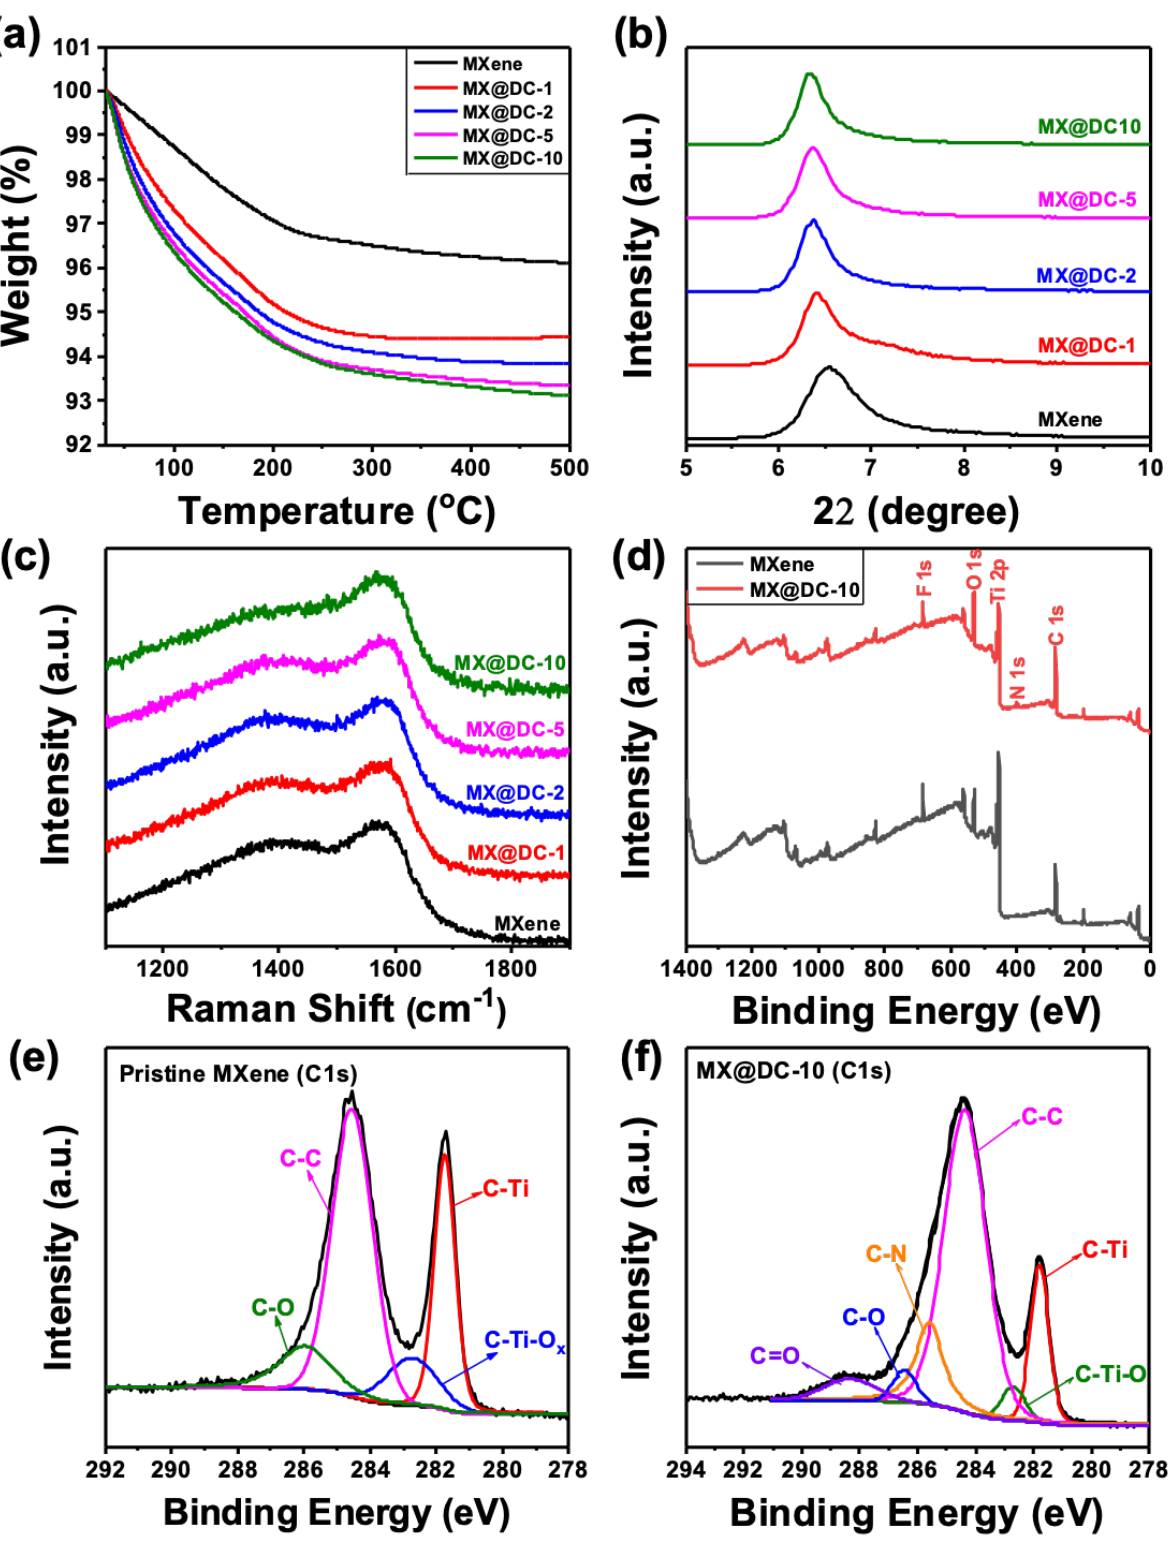
Figure 3. ( a ) TGA curve, ( b ) XRD patterns, and ( c ) Raman spectra of MXene and MX@DC − x films as a function of DC content. ( d ) Full − range XPS spectra of MXene and MX@DC − 10 films. ( e , f ) Deconvoluted XPS C 1s of MXene and MX@DC − 10 films, respectively.